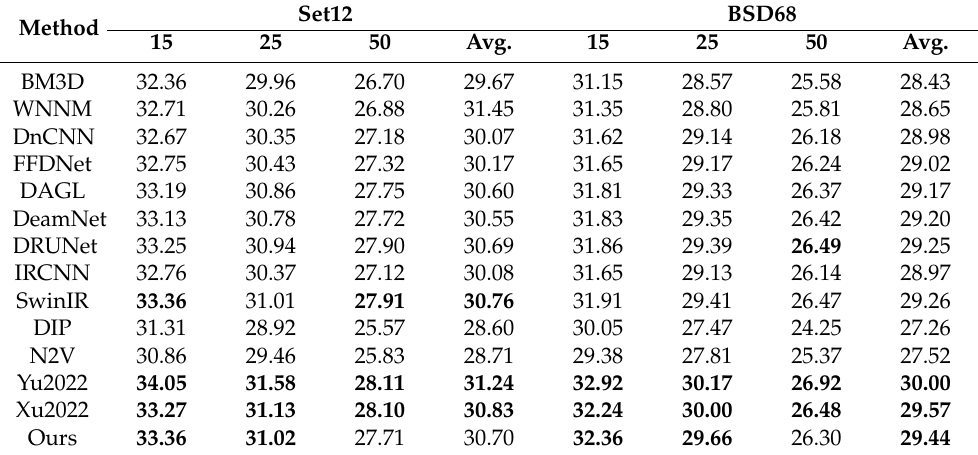
Table 3. Comparison of the averaged PSNR (dB) of different methods on the Set12 and BSD68 datasets. The best three performances are highlighted in boldface.